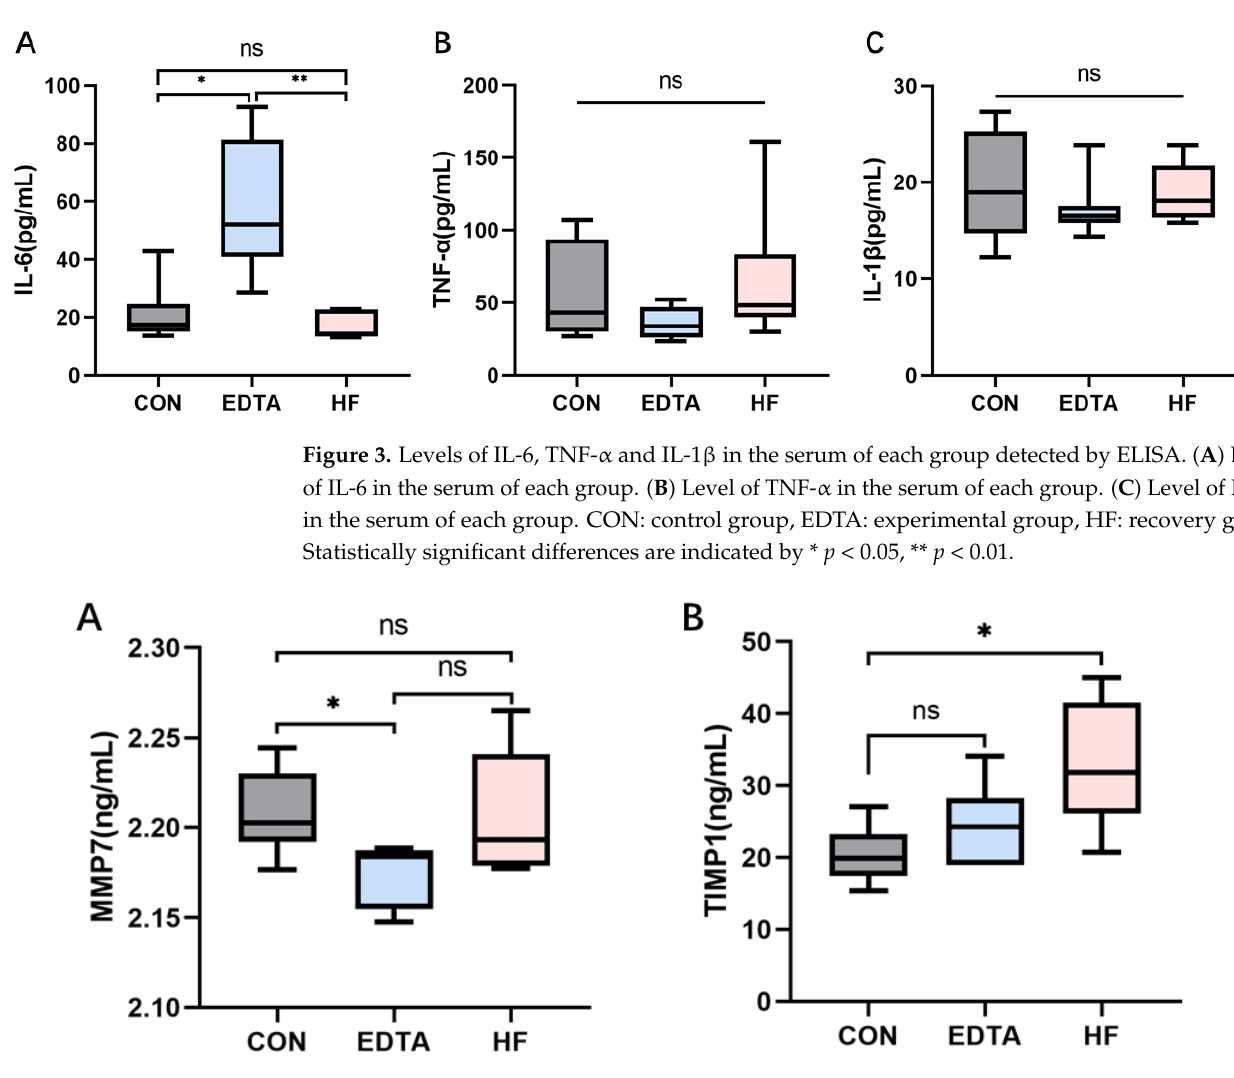
Figure 4. Levels of MMP7 and TIMP1 in the serum of each group detected by ELISA. ( A ) Level of MMP7 in the serum of each group. ( B ) Level of TIMP1 in the serum of each group. CON: control group, EDTA: experimental group, HF: recovery group. Statistically significant differences are indicated by * p <